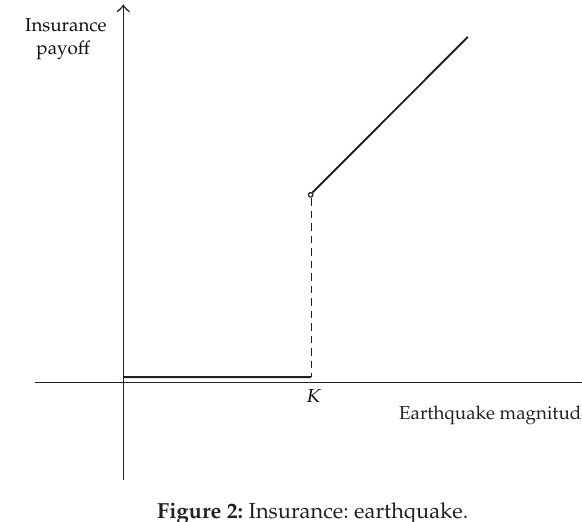
Figure 2: Insurance: earthquake.